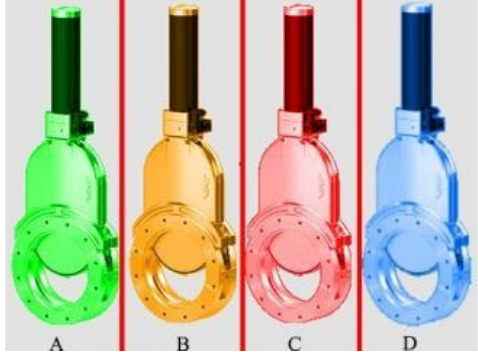
Fig. 4. Color codes of the beam elements of METU-DBL. While green color shows the ideal status, yellow color indicates the warning status. The red color shows the error status and the blue color indicates the safe status.